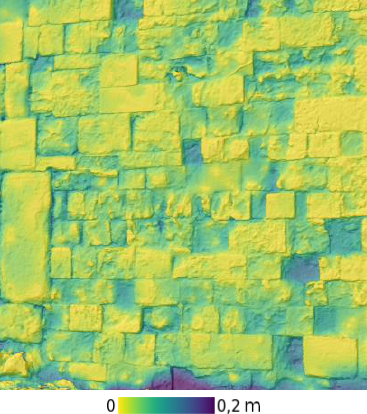
Figure 14. Material loss estimation using the valley depth algorithm (hillshade has been added as background for easier interpretation of the results)